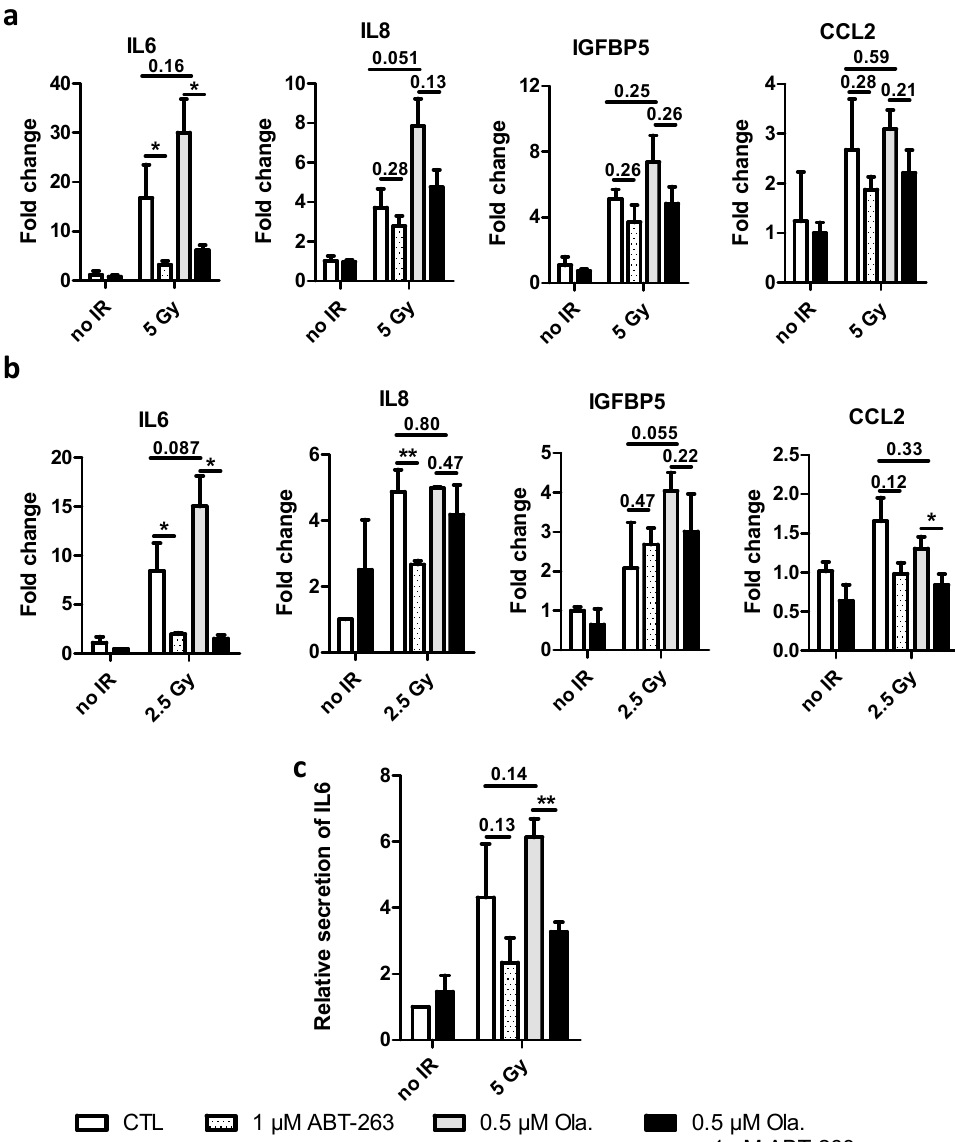
Figure 5. ABT-263 reduces the SASP promoted by Olaparib and radiations in A549 cells. A549 cells were irradiated with 5 Gy X-rays or 2.5 Gy protons with or without 0.5 µM of Olaparib. The medium was replaced 22 h after irradiation, and 1 µM of ABT-263 was added. ( a , b ) 3 days post-irradiation, mRNA level of genes implicated in SASP were determined. Fold changes, calculated as 2 −ΔΔ ct , are presented after X-rays ( a ) and protons ( b ) radiation. ( c ) Relative secretion of IL6 six days after X-rays. At least three independent experiments were performed, and data are presented as mean ± 1 SD. Unpaired t -tests were performed (*: p < 0.05; **: p < 0.01) for CTL vs. ABT, CTL vs. Ola and Ola vs. Ola + ABT.